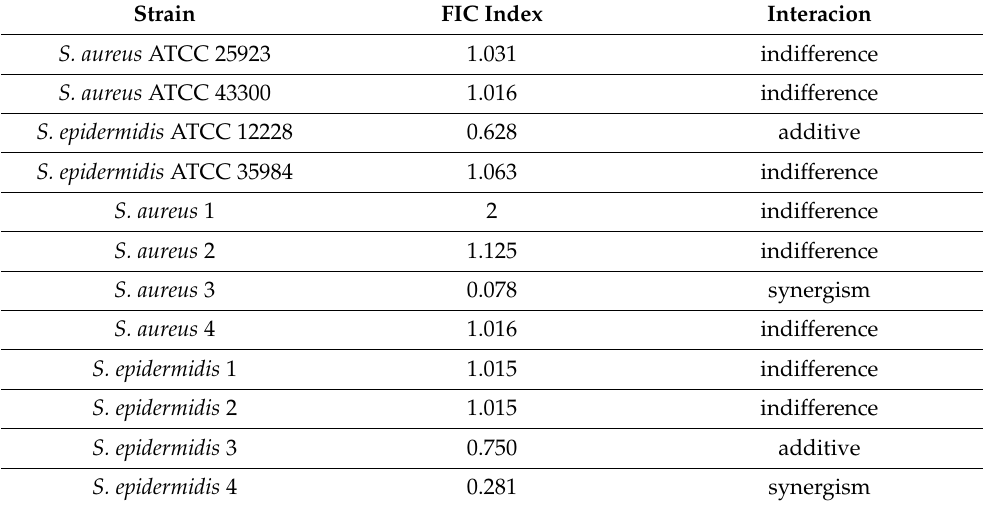
Table 3. FIC index and their interpretation.